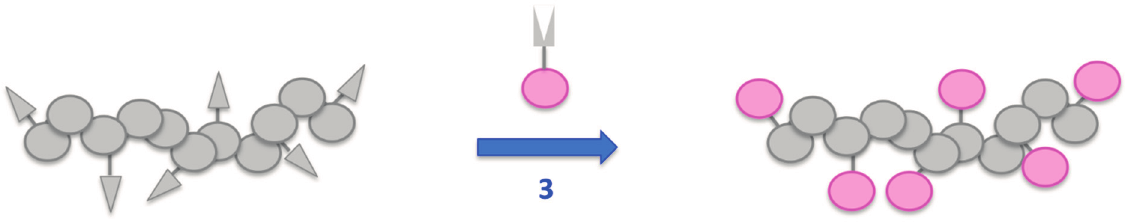
Figure 7. Schematic illustration of the polymer analogous attachment of dye